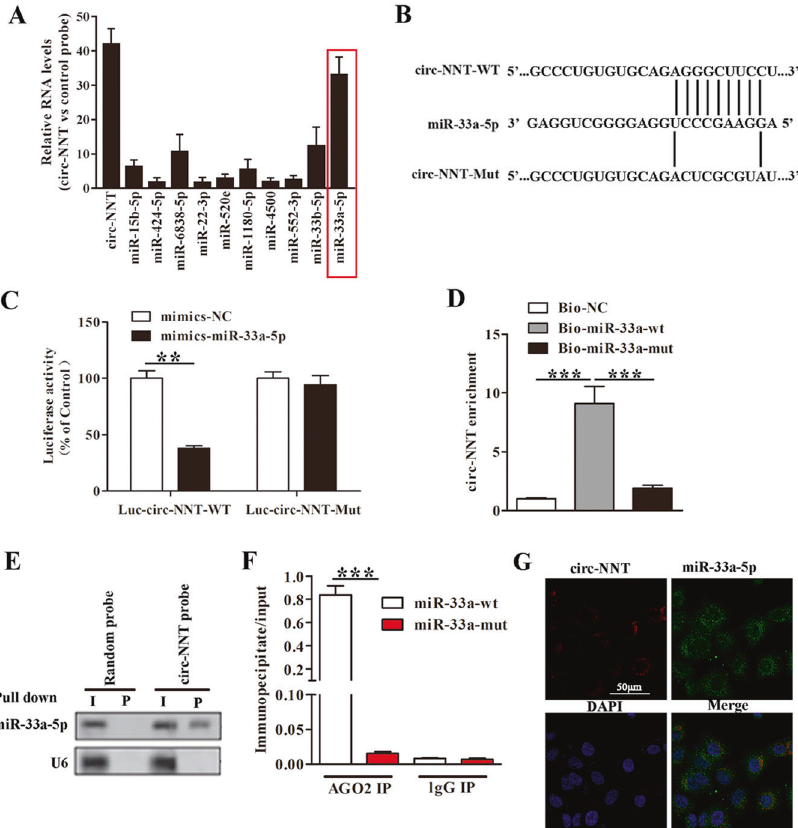
Fig. 4 Circ-NNT directly binds to miR-33a-5p in cardiomyocytes. A Sequences of circ-NNT segment containing the putative miR-33a-5p binding site (circ-NNT-WT) and a mutant circ-NNT segment (circ-NNT-Mut) with mutations at the putative miR-33a-5p binding site are shown. B Cardiomyocytes were transfected with mimics-miR-33a-5p/mimics-NC along with the luciferase construct carrying circ-NNT-WT or circ-NNT- Mut as indicated. The luciferase activity was detected after 48 h transfection, n = 3. C circRNA immunoprecipitation assays were performed in circ-NNT-overexpressing 293 T cells using a circ-NNT-speci fi c probe and control probe, respectively. The enrichment of circ-NNT and microRNAs was detected by qRT-PCR and normalized to the control probe. D Cardiomyocytes were transfected with Bio-miR-33a-5p-WT, Bio- miR-33a-5p-Mut or Bio-NC. RNAs bound to the biotinylated probe were collected by biotin-based pull down assays, and the circ-NNT enrichment was detected by RT-PCR, n = 3. E Cardiomyocytes lysates were incubated with circ-NNT probe or random probe-coated magnetic beads. RNAs bound to the beads were extracted, and miR-33a-5p was detected by northern blot analysis. I, input (10% samples were loaded); P, pellet (100% samples were loaded). F Cardiomyocytes were transfected with miR-33a-5p-WT or miR-33a-5p-Mut. RNAs bound to anti-AGO2 antibody or IgG-coated sepharose beads were collected by AGO2 immunoprecipitation assays, and circ-NNT was detected by RT-PCR. The immunoprecipitate/input ratios are shown, n = 5. G Cardiomyocytes were co-transfected with circ-NNT and miR-33a-5p. Co-localization of circ- NNT and miR-33a-5p were visualized by situ hybridization. Cells were stained with DAPI. * P < 0.05, ** P < 0.01, *** P <